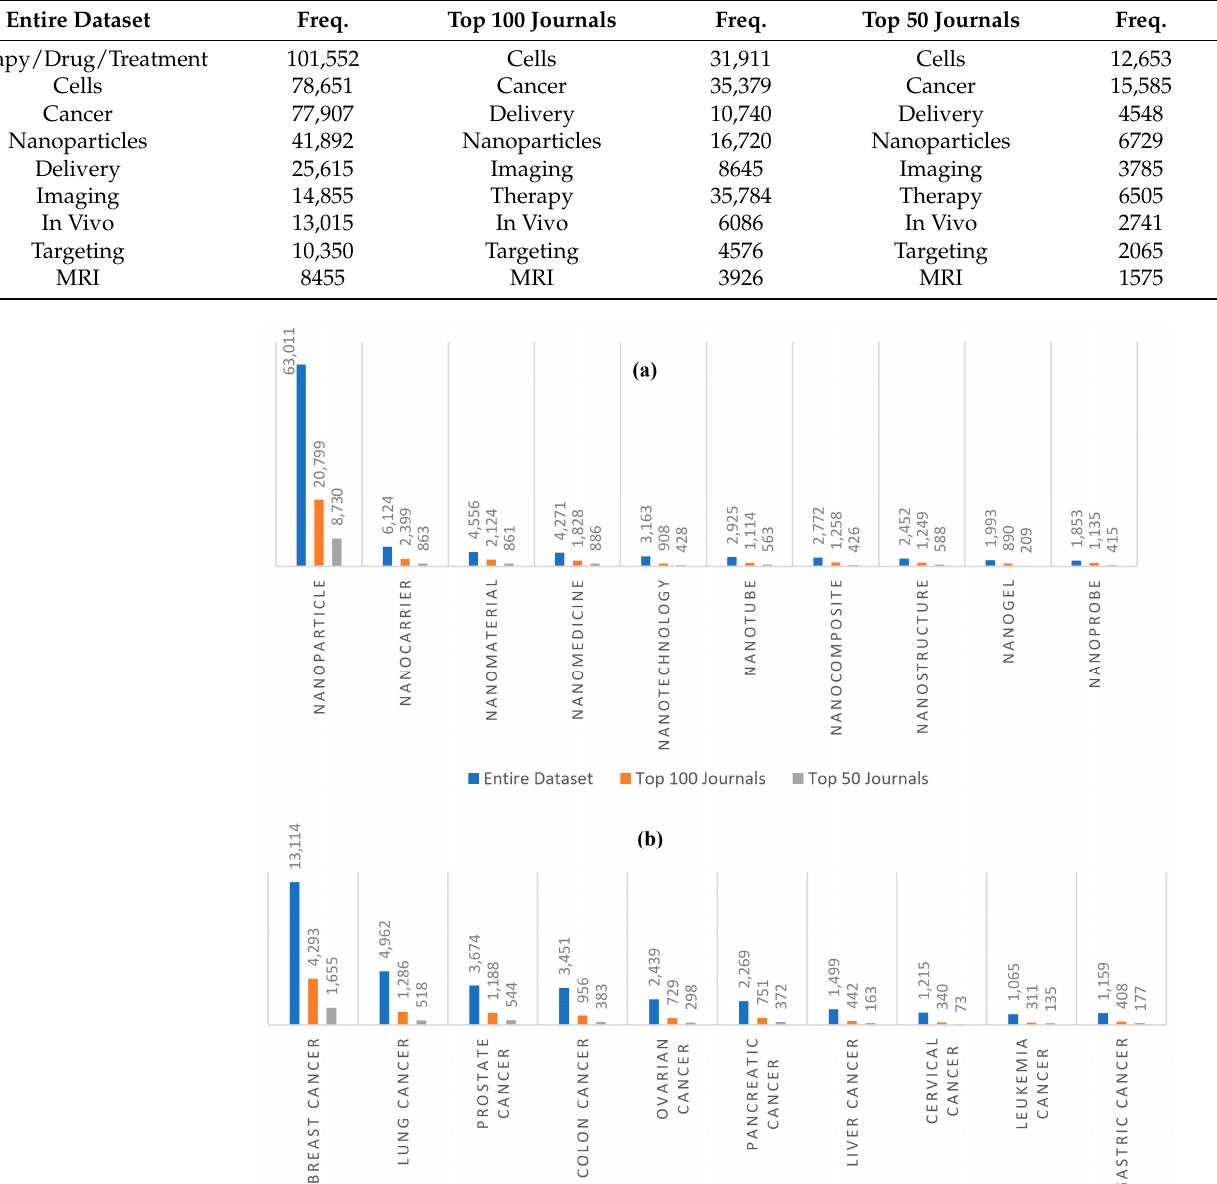
Figure 6. ( a ) The top 10 co-occurring nano keywords and ( b ) cancer